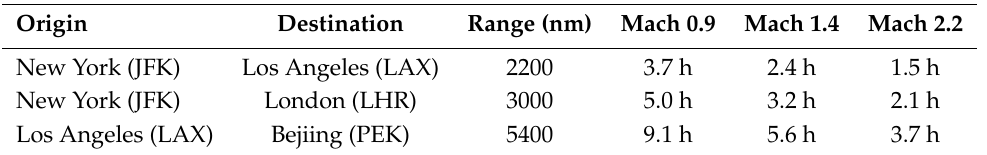
Table 1. Example of flight time reductions due to supersonic cruise (cruise speed is assumed for the full route). From